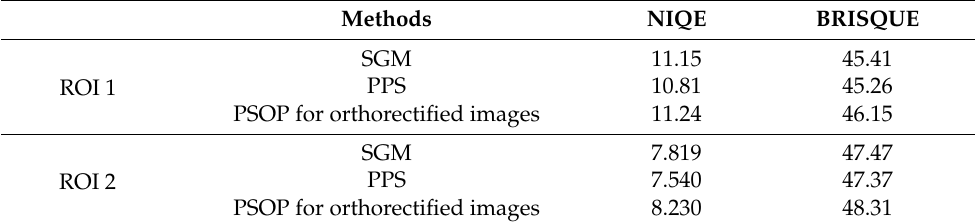
Table 6. Quantitative measures of DEMs by three methods for Yutu-2 images.